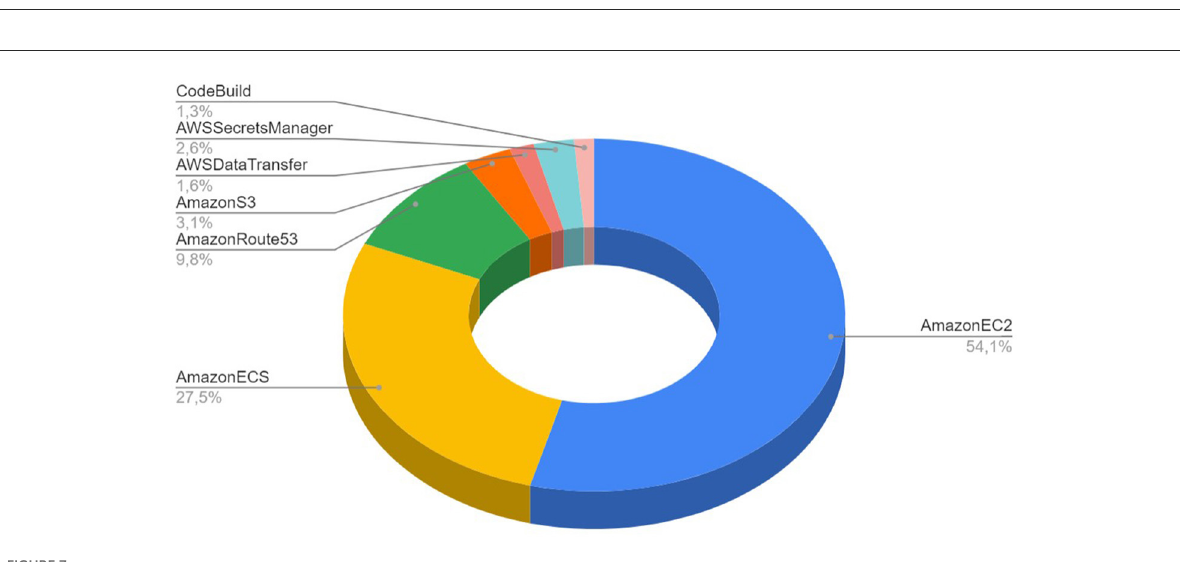
FIGURE7 Cost structure for 18 simulations run using Neural Simulation Pipeline on AWS public cloud